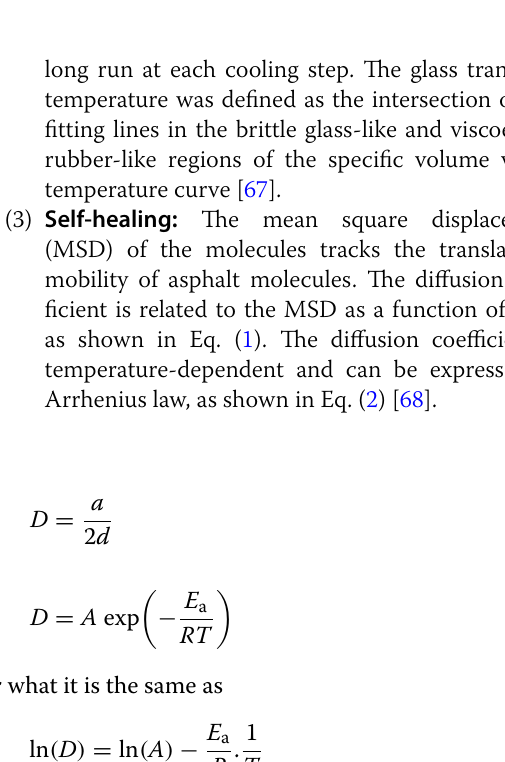
Fig. 7 Density Curves of the Asphalt Models at 333 K during 20 ns All-Atom MD Simulations. It shall be noted that VA is for virgin asphalt, SA is for short-term aged asphalt, and LA is for long-term aged asphalt. The number with the labels indicates the corresponding nano-SiO 2 modified asphalt and the size of the number is the radius of the nano-SiO 2 particles with the unit of